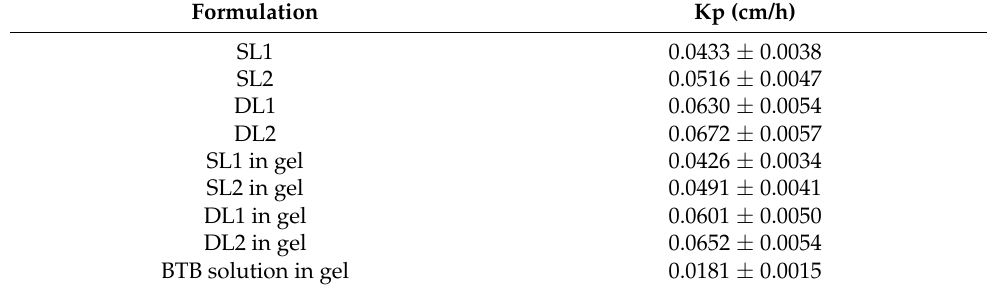
Table 4. Permeability coefficient (Kp) of butamben (BTB) from the different formulations (mean ± SD, n = 6).